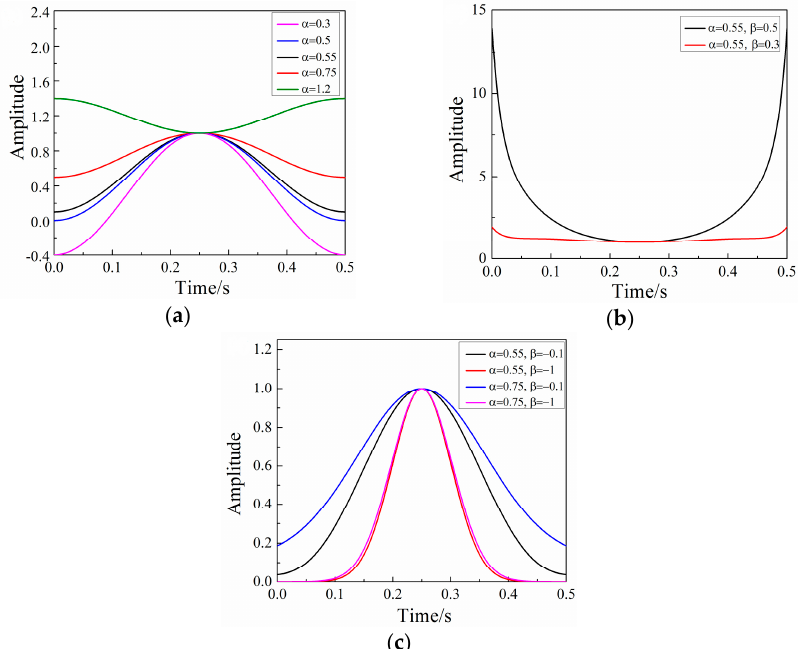
Figure 3. The influence of different α and β values on exponential decay function; ( a ) The exponential decay effect of different values of α ; ( b ) The exponential decay effect of different values of β ; ( c ) The exponential decay effect of different values of α and β .